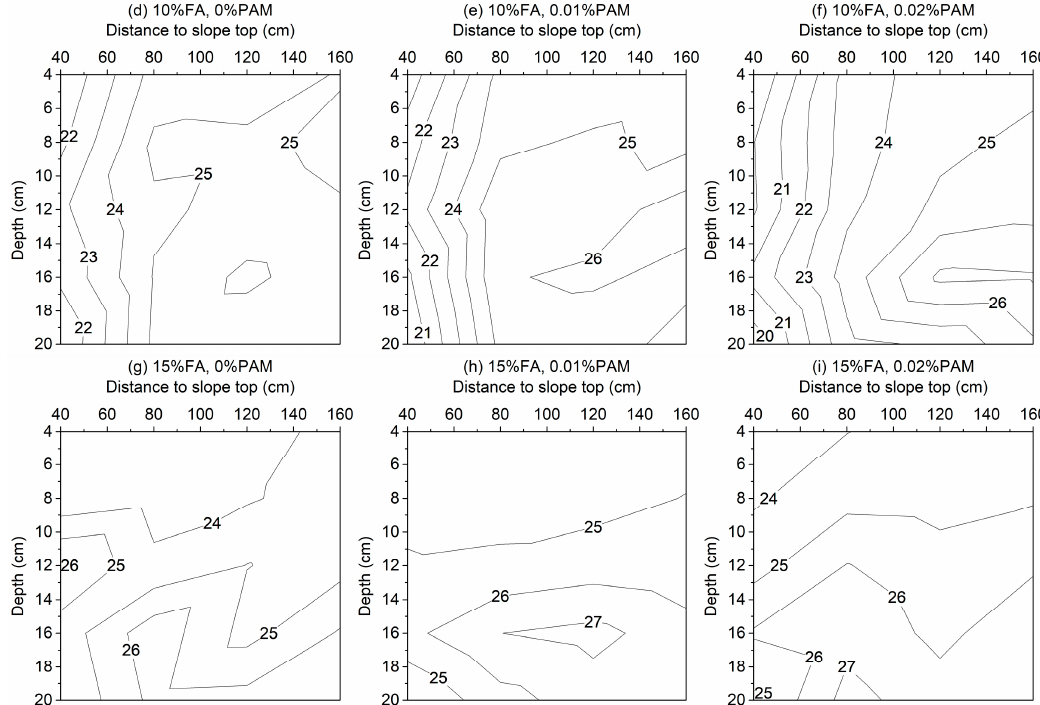
Figure 8. Contour plot showing redistribution of gravimetric water content retained in soil profile for different treatments after rainfall.